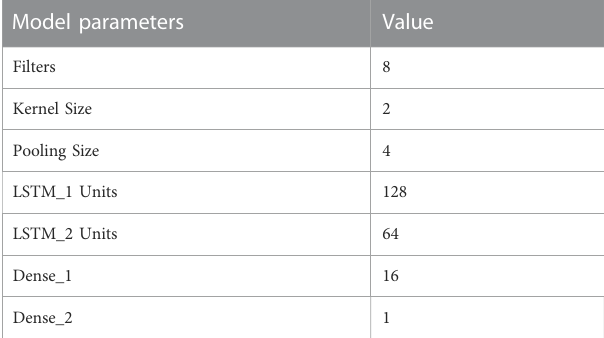
TABLE 2 Parameters of CNN + LSTM. Model parameters